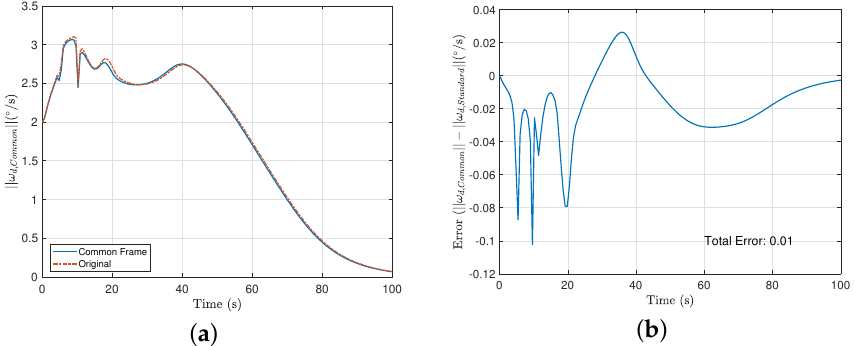
Figure 12. Transient time of the maneuver for the steering law where ( a ) is the overall commanded rates of the steering law, and ( b ) is the error plot of ( a